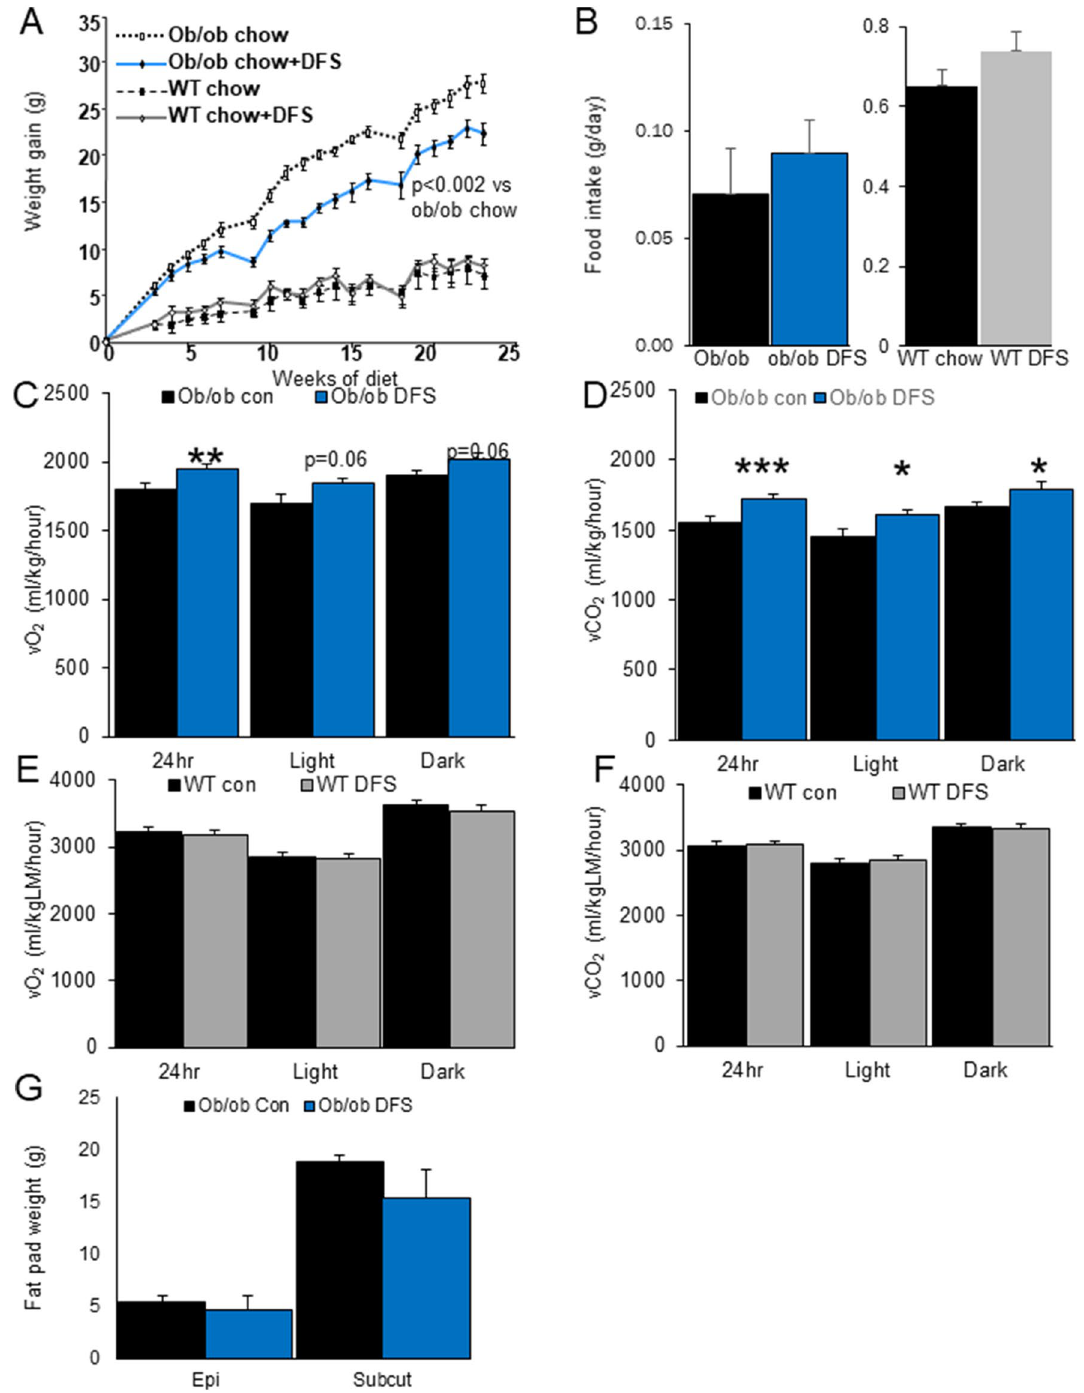
Figure 5. Deferasirox decreases weight gain in ob/ob leptin deficient mice. ( A ) DFS + chow resulted in lower weight gain in ob/ob mice compared to mice eating chow. ( B ) Food intake was not decreased in ob/ob mice eating DFS. ( C ) Oxygen consumption (vO 2 ) was higher in ob/ob chow + DFS mice. ( D ) Carbon dioxide production (vCO 2 ) was also higher in ob/ob chow + DFS mice. ( E ) No differences in vO 2 were seen in chow versus chow + DFS fed wild type littermates. ( F ) No differences in vCO 2 were seen in chow versus chow + DFS fed wild type littermates. ( G ) Fat pad weights of epigonadal and subcutaneous inguinal fat of ob/ob mice at sacrifice. *p < 0.05, **p < 0.01, ***p < 0.001. Data is shown as mean ± SEM (standard error of the mean) unless otherwise